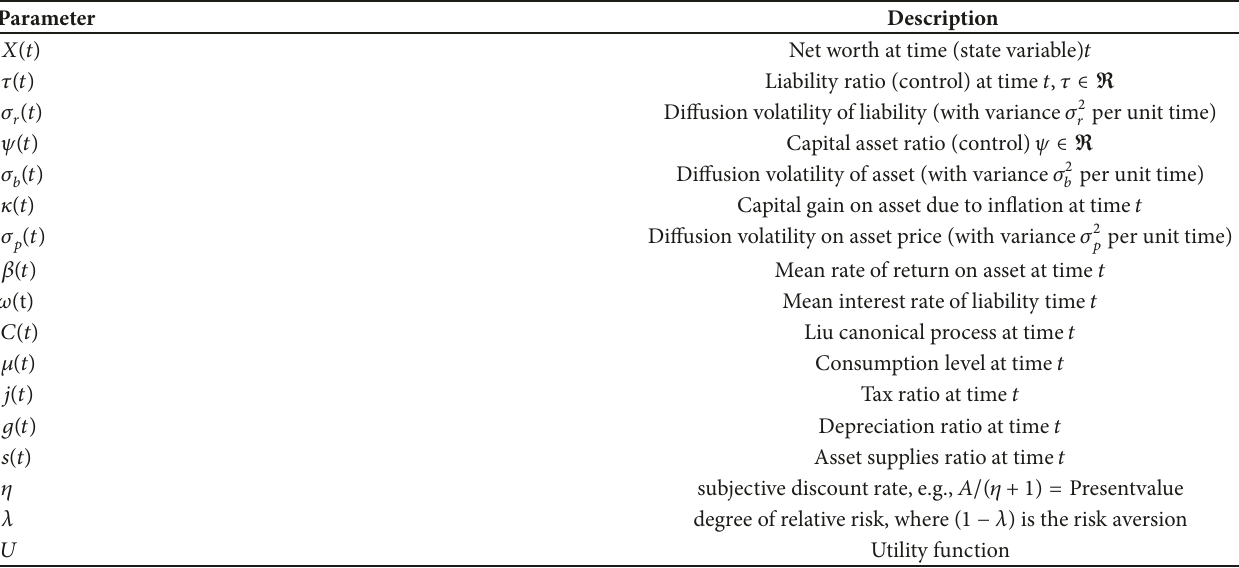
Table 2: Definition of parameters to the